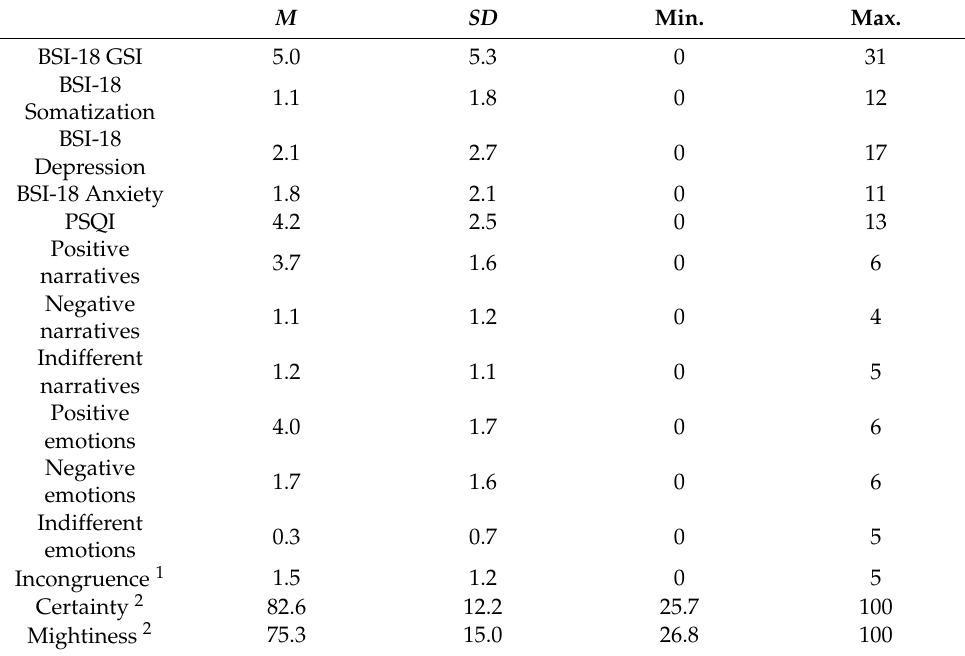
Table 1. Descriptive statistics of psychiatric symptoms and credition parameters. M SD Min. Max.